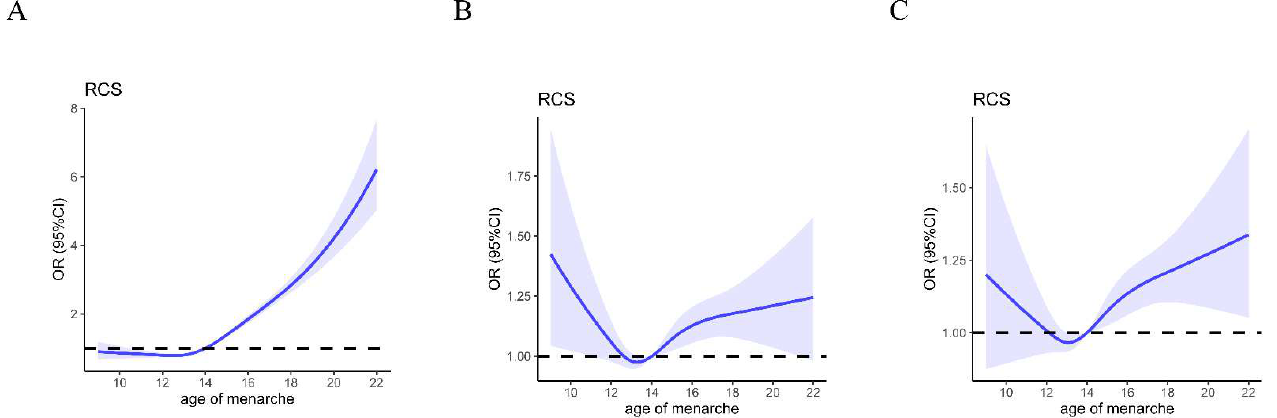
Figure 3. Curve of the association between hypertension risk and per year increase in menarche age. The solid line represents the estimated odds ratio for hypertension risk and the shaded areas represent 95%CI. ( A ) Results using the crude model cubic spline regression analyses. ( B ) Results using the model 1 cubic spline regression analyses. ( C ) Results using the model 2 cubic spline regression analyses. Table 2. Associations between menarche age and hypertension by age at recruitment.